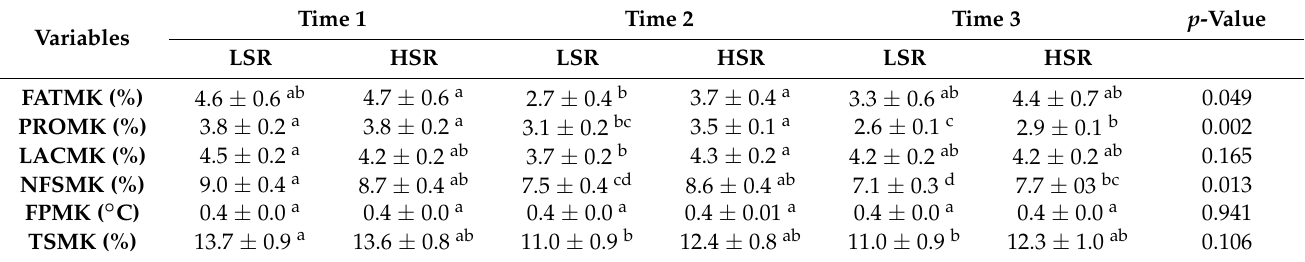
Table 6. Least-square means ± standard error for the interaction social rank (i.e., LSR and HSR) and time (i.e., 3 times) regarding the goat milk constituents for fat (FATMK, %), protein (PROMK, %), lactose (LACMK), %), nonfat solids (NFSMK, %), freezing point (FPMK, units), and total solids (TSMK, %) according to the social rank (i.e., LSR and HSR) and time (i.e., 3 times) in crossbred (Alpine–Saanen–Nubian × Criollo; n = 15) dairy goats in northern Mexico (25 ◦ N) 1,2